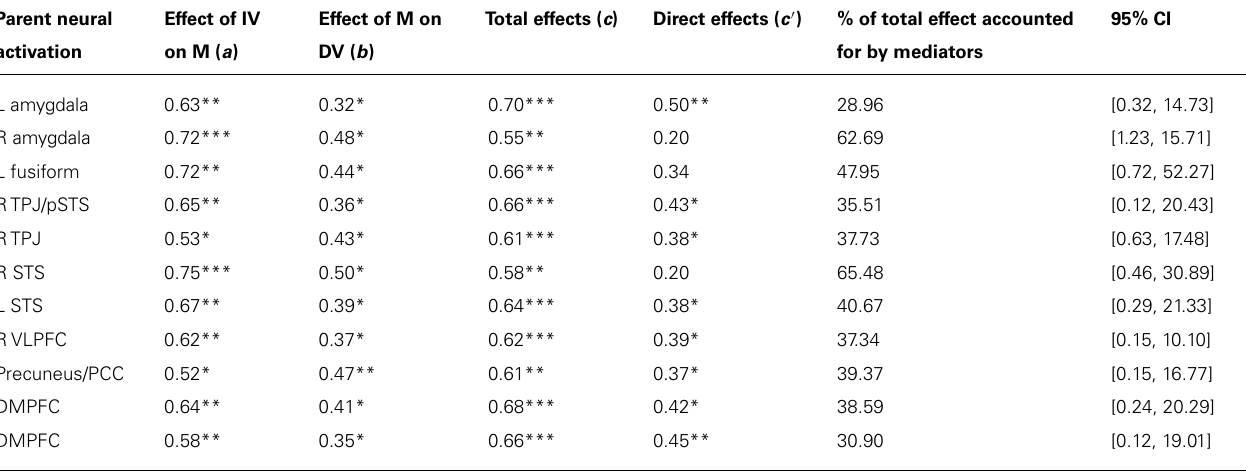
Table 6 |AdolescentTPJ as a mediator of parental neural sensitivity and adolescent emotional competence. Parent